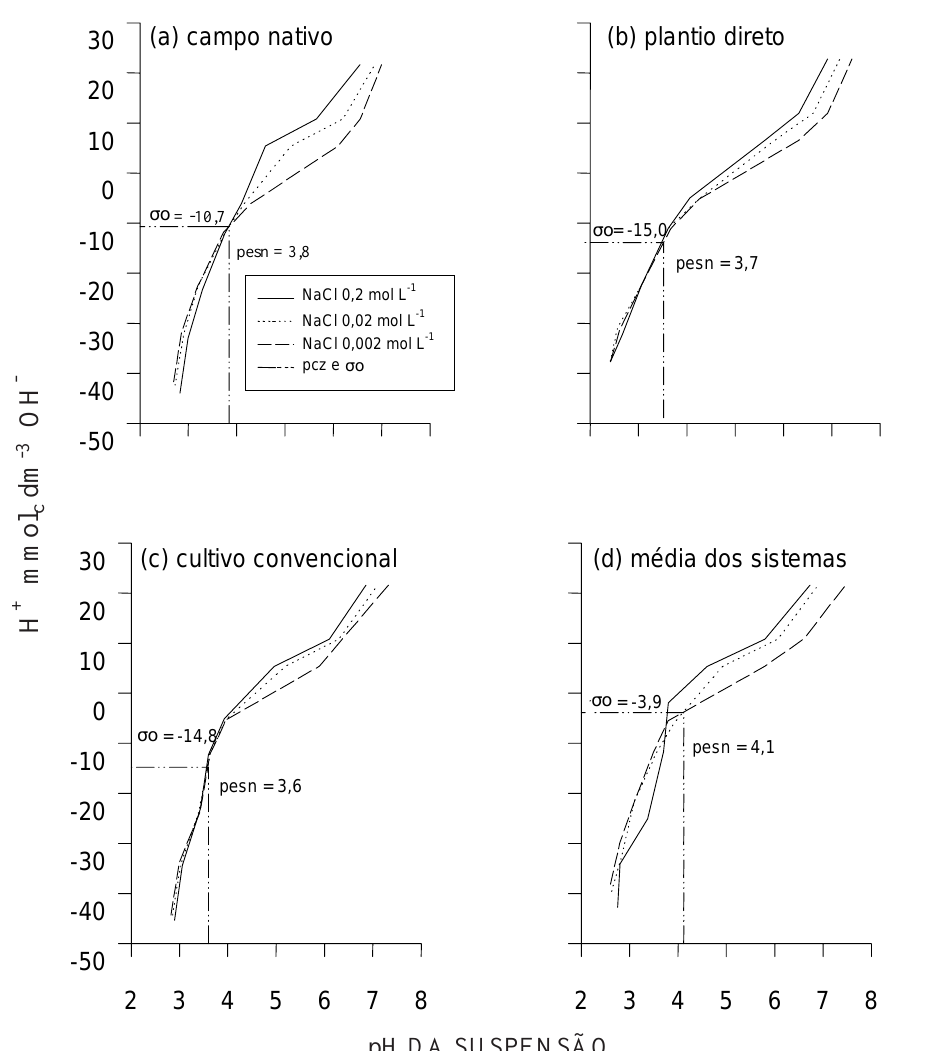
Figura 1. Ponto de efeito salino nulo (pesn) e cargas negativas permanentes ( sssss o) do Podzólico Vermelho- Amarelo textura arenosa/argilosa para (a) campo nativo, (b) sistema plantio direto e (c) cultivo convencional na camada de 0-5 cm e (d) média dos três sistemas e das camadas de 5-10, 10-20 e 20-40